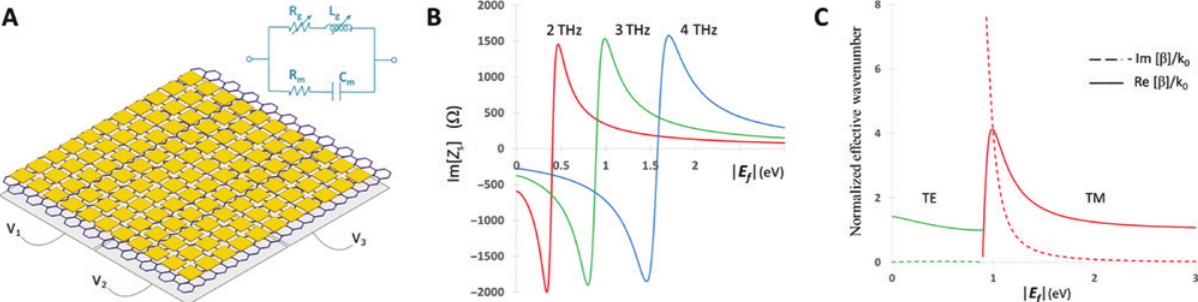
Figure 3: Details of the proposed structure and associated properties. (A) Schematic of the proposed LW platform based on graphene-metasurface and the corresponding circuit model of a parallel transmission line in the inset, (B) the surface reactance of the structure as a function of chemical potential at different frequencies, and (C) the associated SW propagation constants as a function of chemical potential at ω /2 π = 3